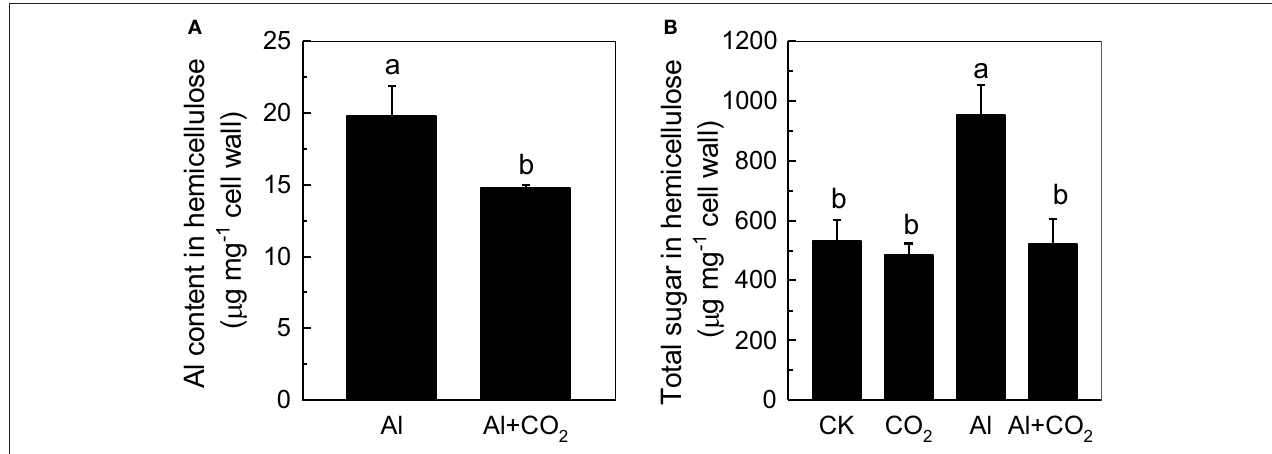
FIGURE 5 | Effects of elevated CO 2 treatment on the Al content (A) and the total sugar content (B) of Kas root cell wall hemicellulose. Three-day-old rice seedlings were treated with 0.5 mM CaCl 2 solution with or without 50 µ M Al under ambient (400 µ L · L − 1 ; CK) or elevated (600 µ L · L − 1 ; CO 2 ) CO 2 for 24 h (pH 4.5). Data are means ± SD ( n = 4). Columns with different letters are significantly different at P < 0.05.